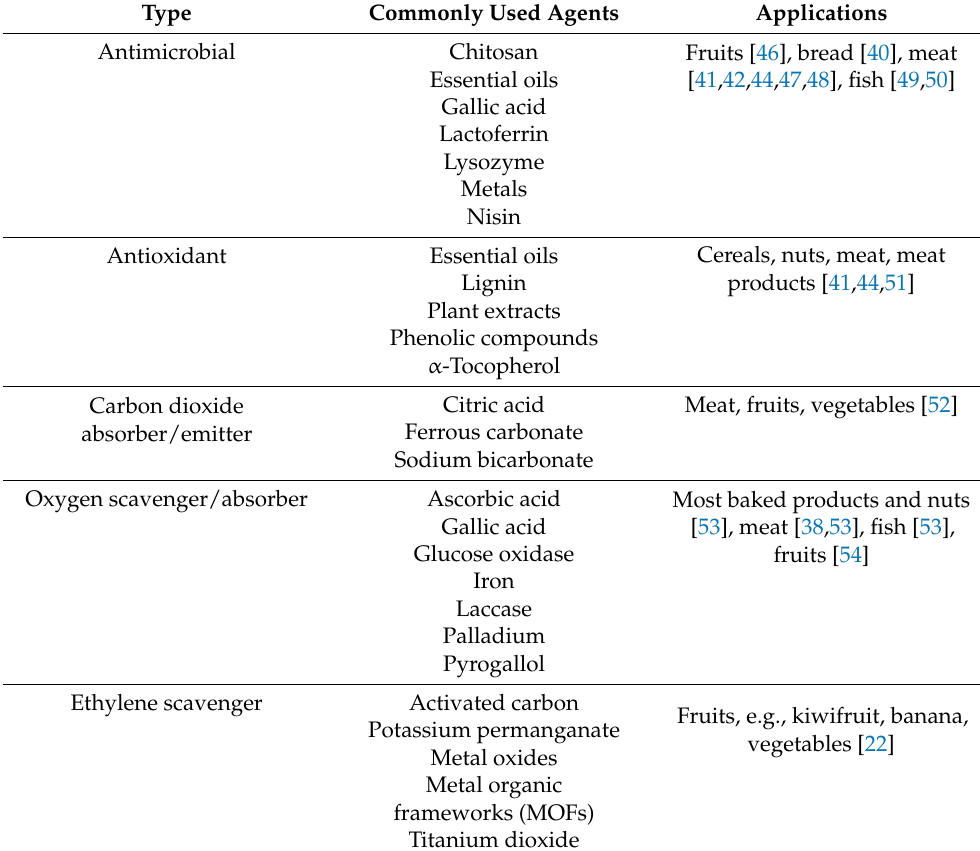
Table 1. Active agents for food